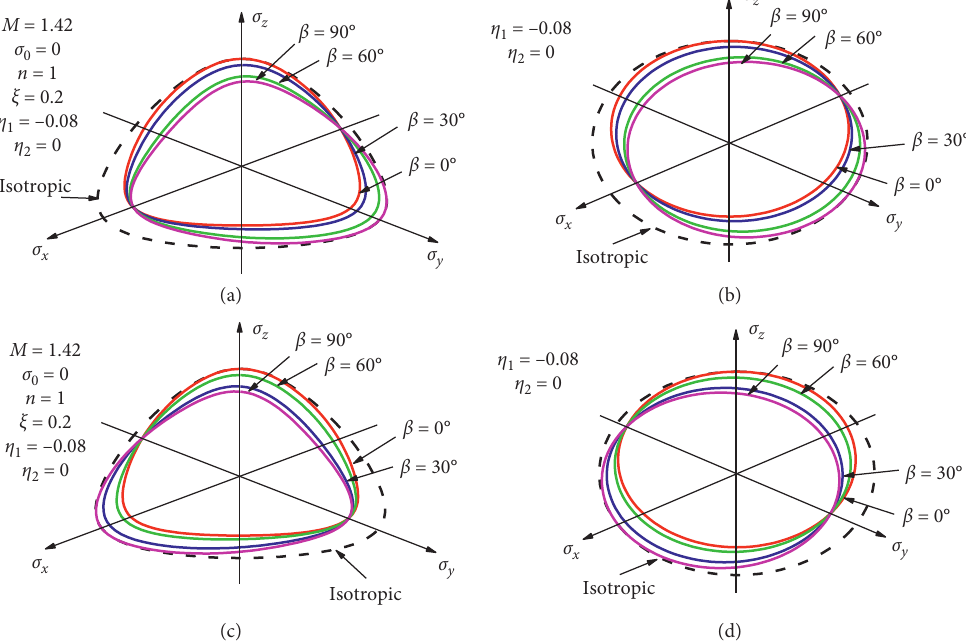
Figure 4: The variations of the failure surface and f ( A ) in the octahedral plane: (a, b) the y − z plane and (c, d) the x − z plane.